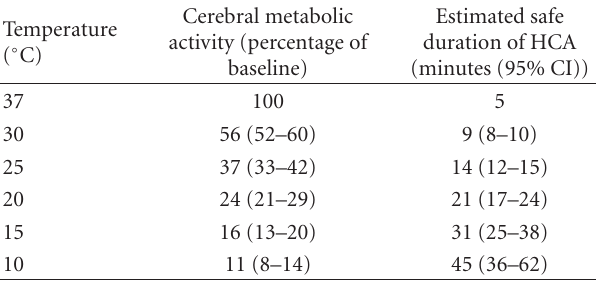
Table 2: Calculations of the safe duration of hypothermic circula- tory arrest (HCA) based on 100% metabolic activity at 37 ◦ C and a safe HCA period of five minutes. Reproduced with permission from McCullough et al.